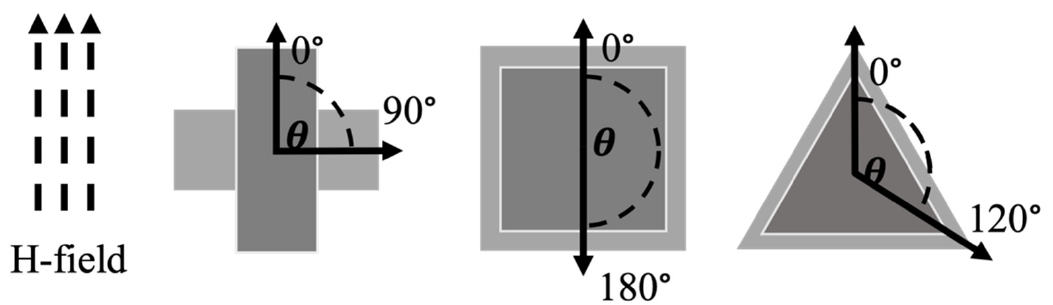
Figure 6. Schematic representation of magnetic field orientation and angles of maximum displacement in this study. The bias and activation fields are applied parallel and coincident with the 0 ◦ alignment of each shape, which is denoted by the darker color configuration. The lighter color configuration shows the same edge/corner that was initially aligned with 0 ◦ but is now aligned with the maximum displacement angle for that shape. The direction of applied fields remained the same throughout the experiments.